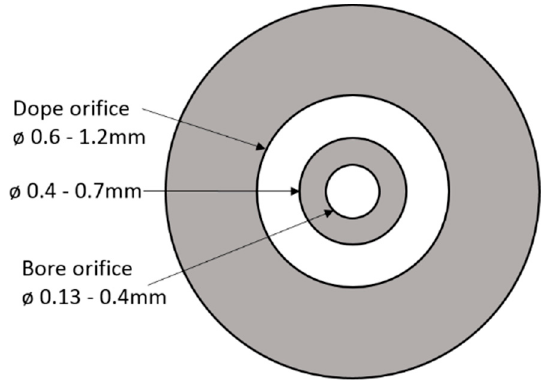
Figure 3. Spinneret type and range of different dimensions used for spinning of CAHF.